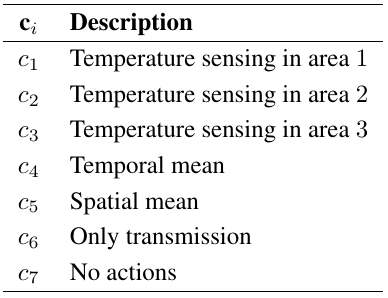
Table 1. Sub-operations for the spatial and temporal monitoring example